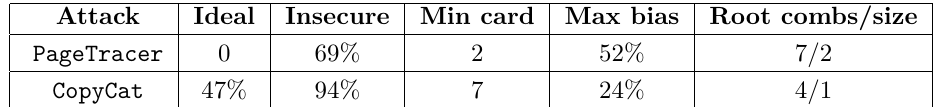
Table 4: wolfSSL combination details.